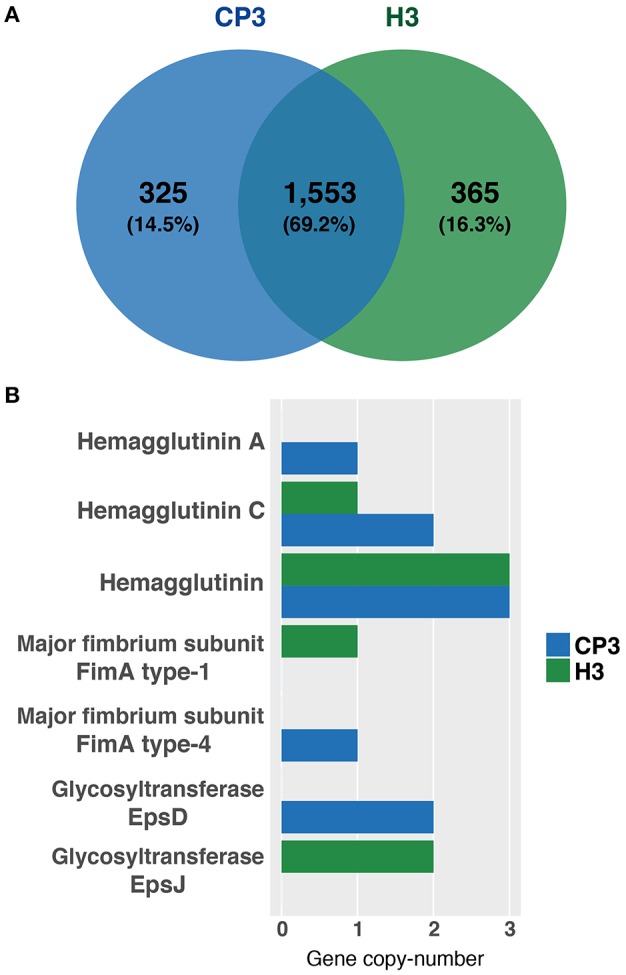
Common genes between Porphyromonas gingivalis CP3 and H3 and differences in the copy-number of virulence genes. (A) Venn diagram showing the number of common and unique genes of CP3 (blue) and H3 (green) genomes. Values in parentheses are the percentage of genes of the total genes in CP3 and H3 pan genome. (B) Bar plot showing six virulence genes that we detected to have differences in their copy-number between CP3 (blue bars) and H3 (green bars) genomes.